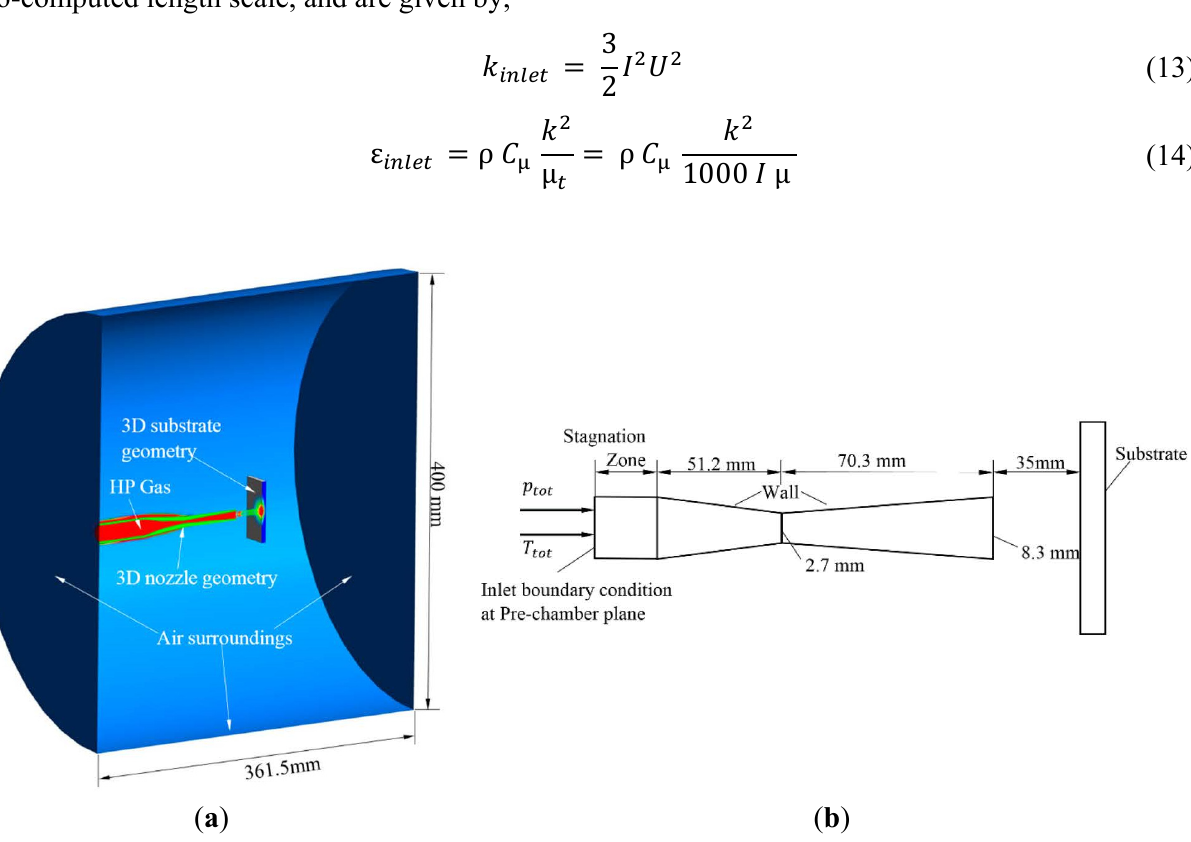
Figure 2. ( a ) Three dimensional representation of cold spray tungsten-carbide nozzle, high pressure nitrogen gas, titanium substrate and surrounding air domains; ( b ) Schematic diagram of cold spray nozzle including